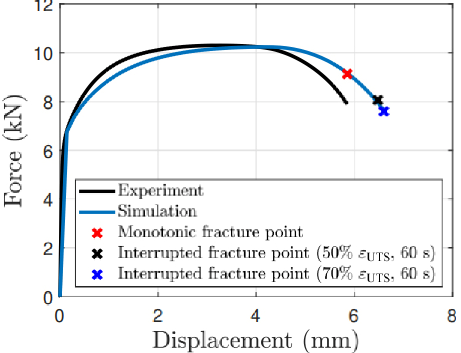
Fig. 10 Force–displacement of UT specimen. Reproduced with permission from Ref. [9], © CIRP 2020.